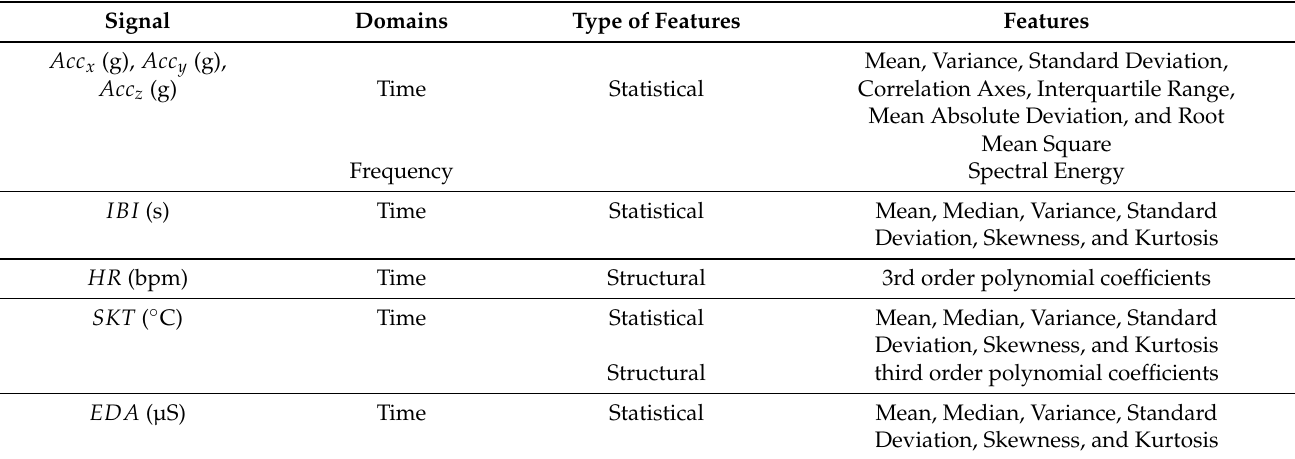
Table 2. List of extracted features from the measured